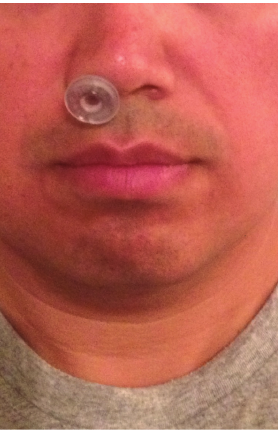
Figure 1: Size 26 nasopharyngeal airway tube in place prior to